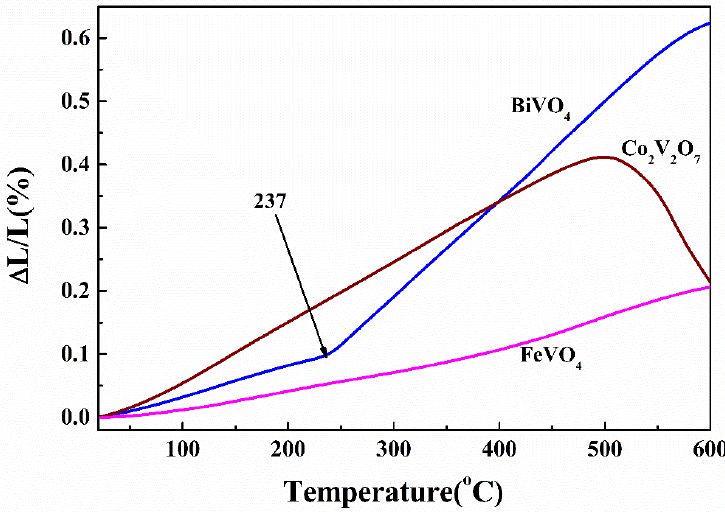
Figure 3. Relative length change of BiVO 4 , FeVO 4 , and Co 2 V 2 O 7.